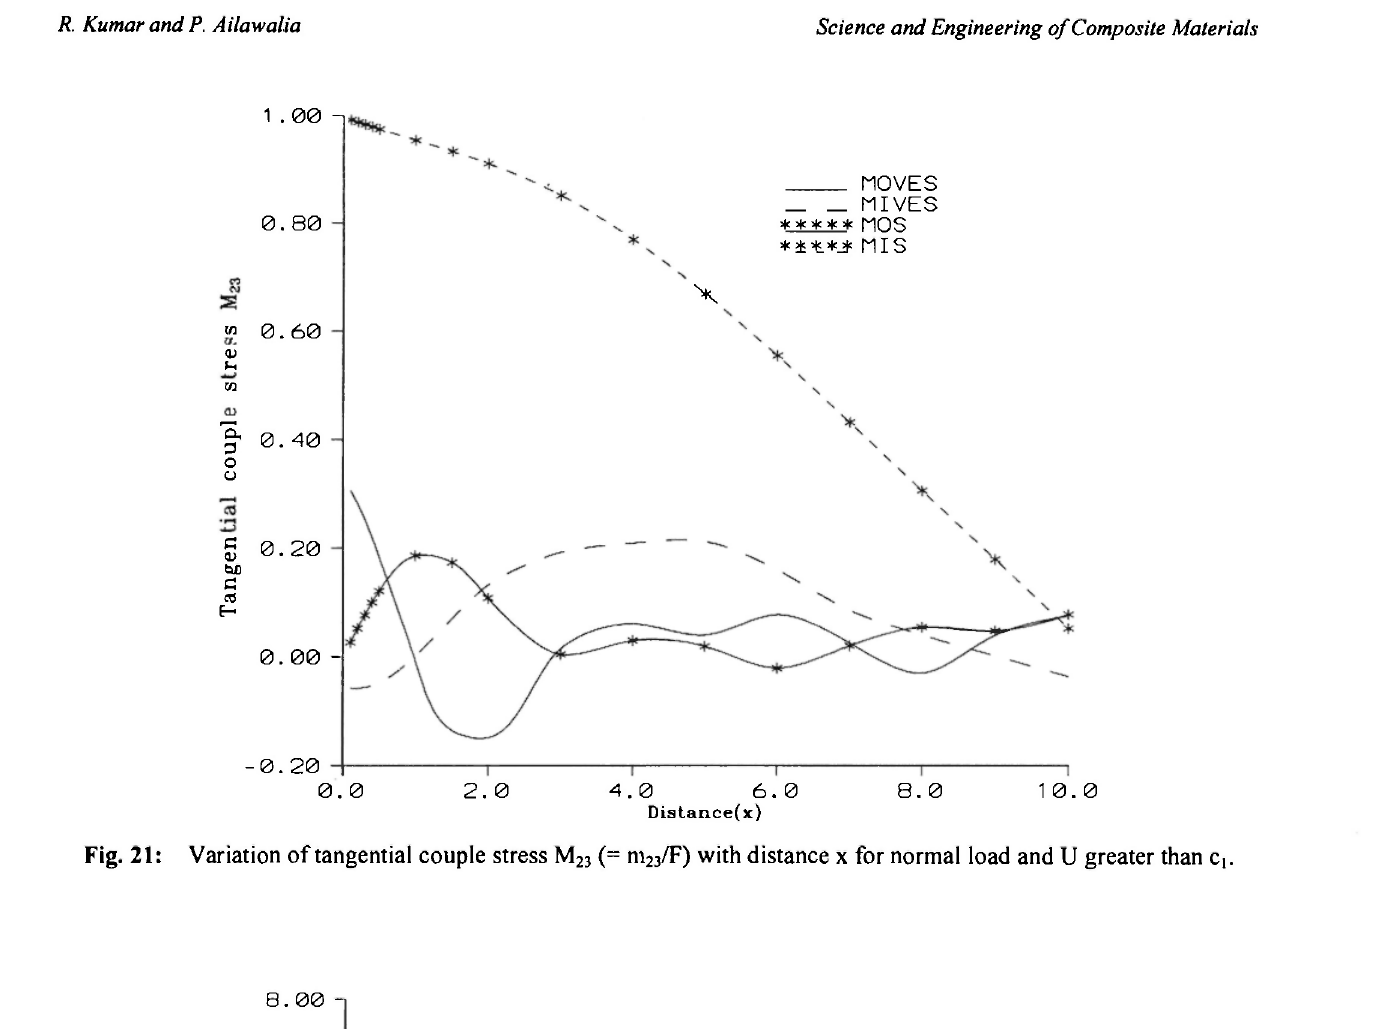
Variation of tangential couple stress M 23 (= n^/F) with distance χ for normal load and U greater than C|.